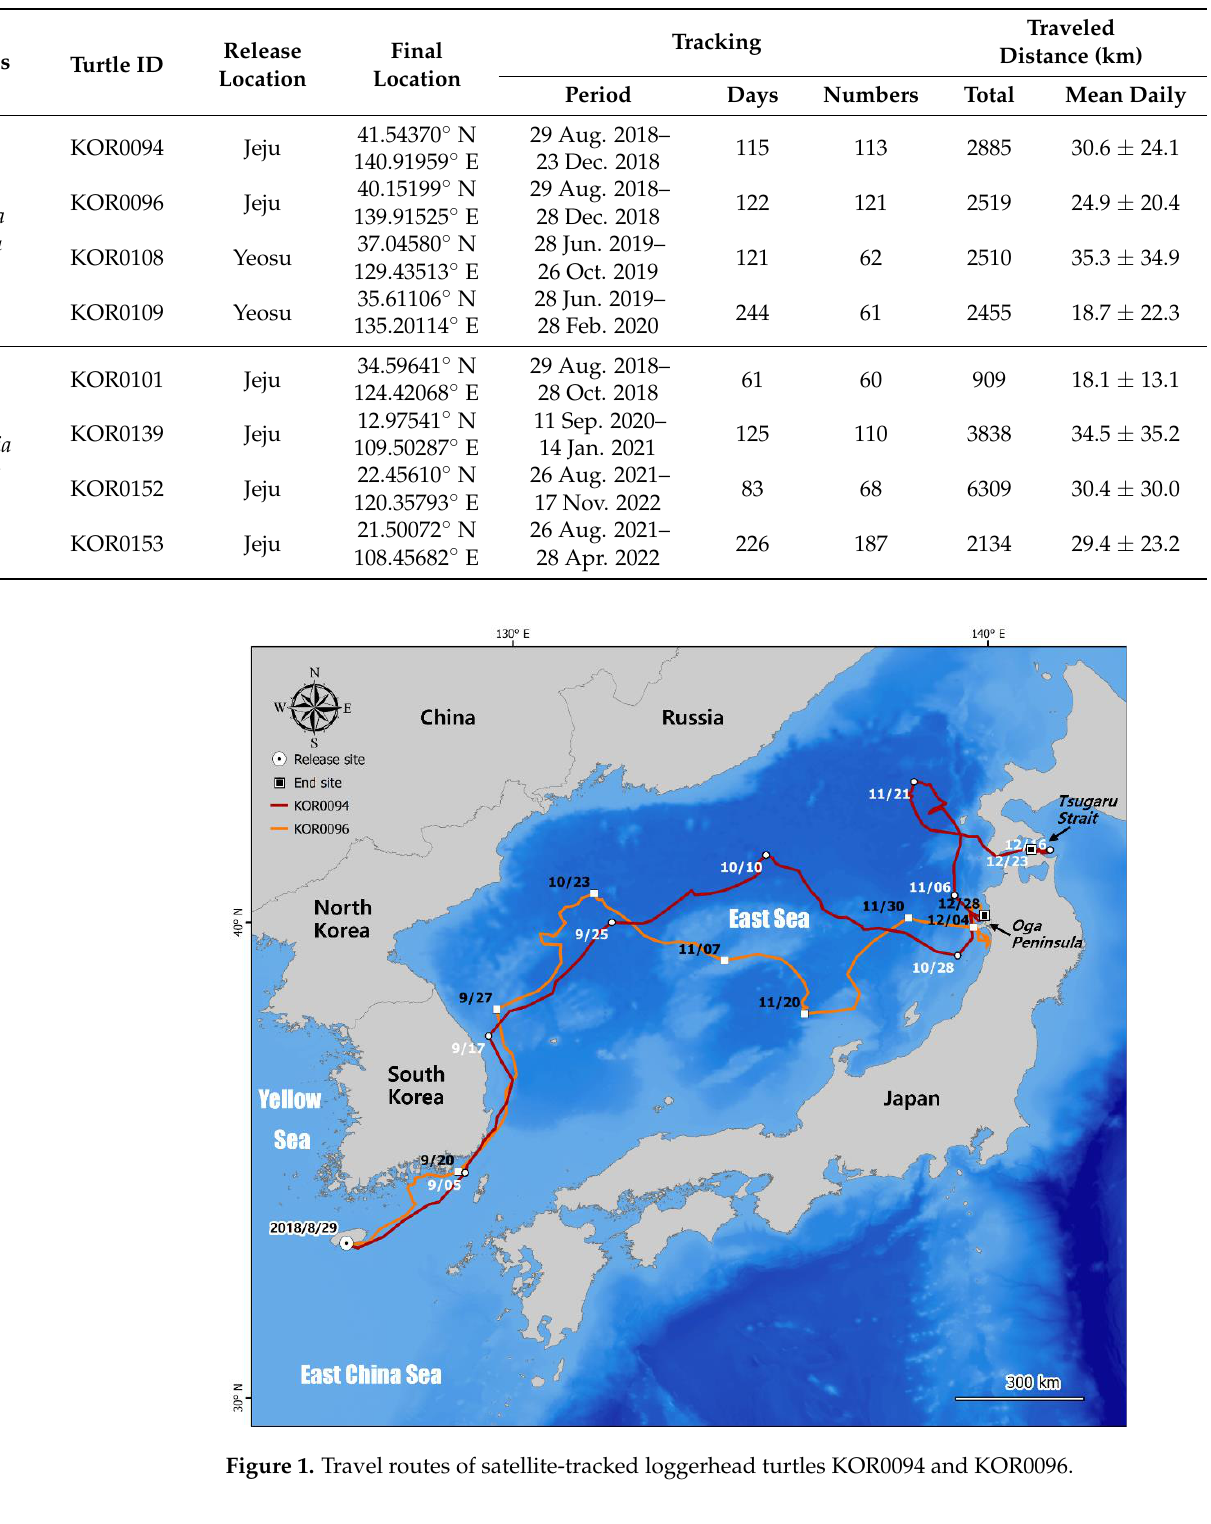
Table 2. Summary of the satellite-tracking of Caretta caretta and Chelonia mydas .